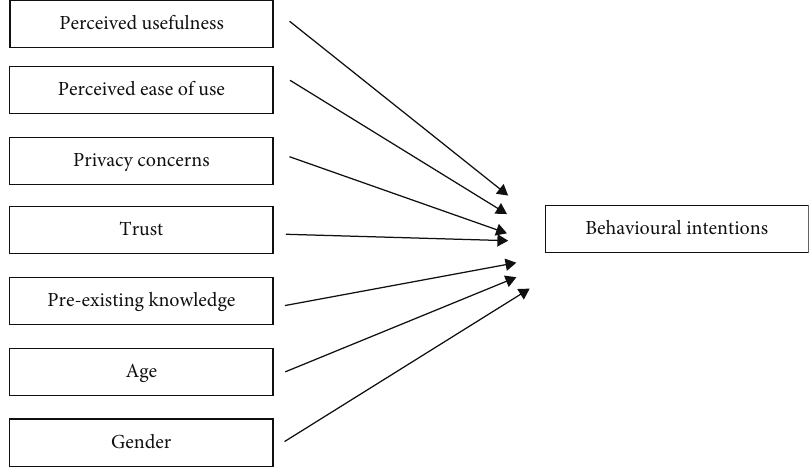
Figure 1: Proposed research